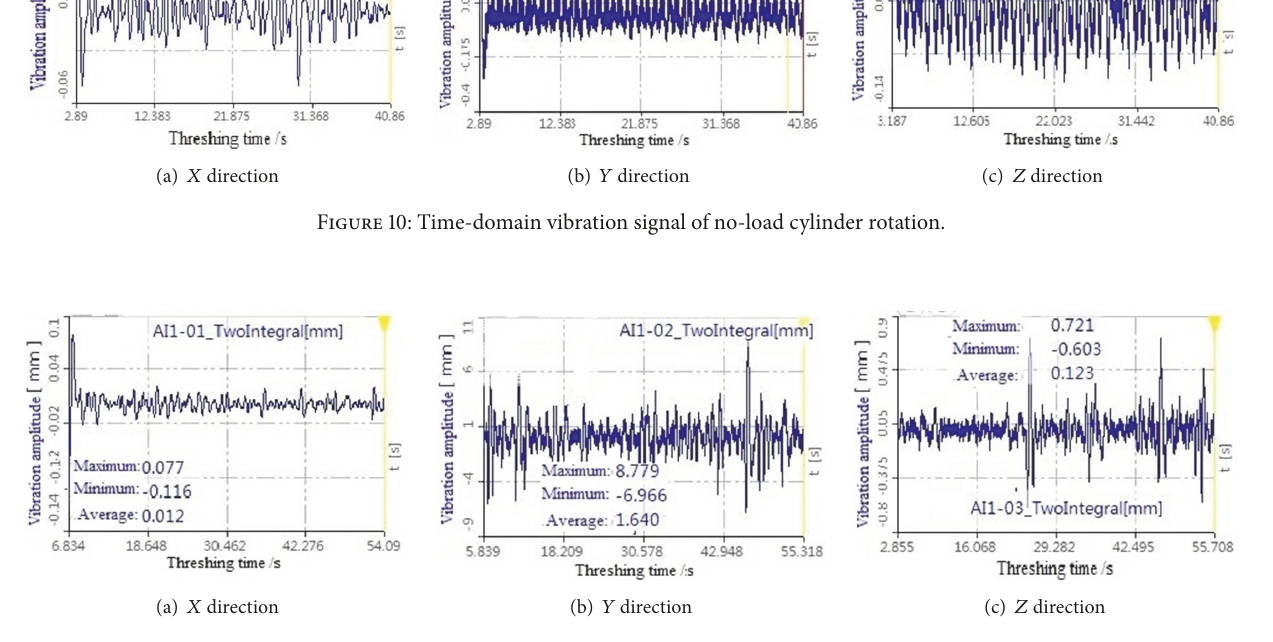
Figure 11: Time-domain vibration signal of rice threshing